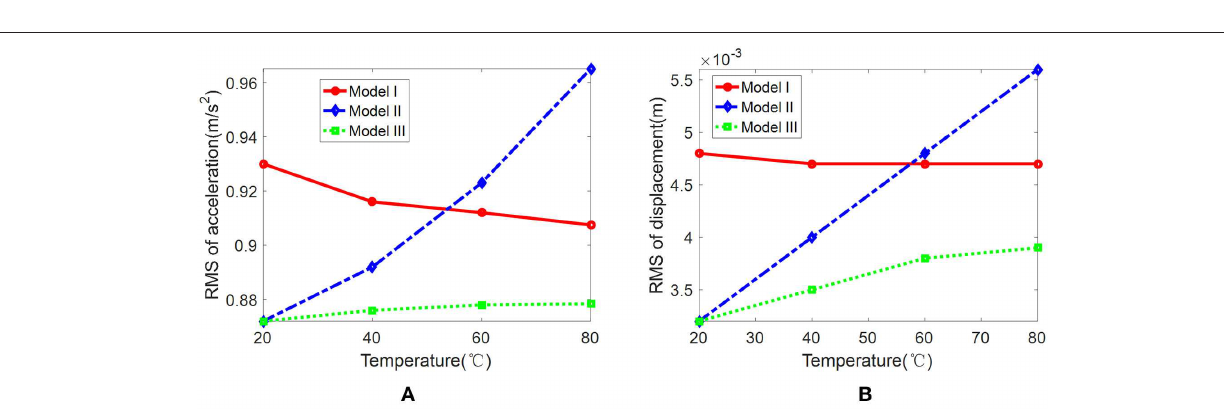
Frontiers in Materials |